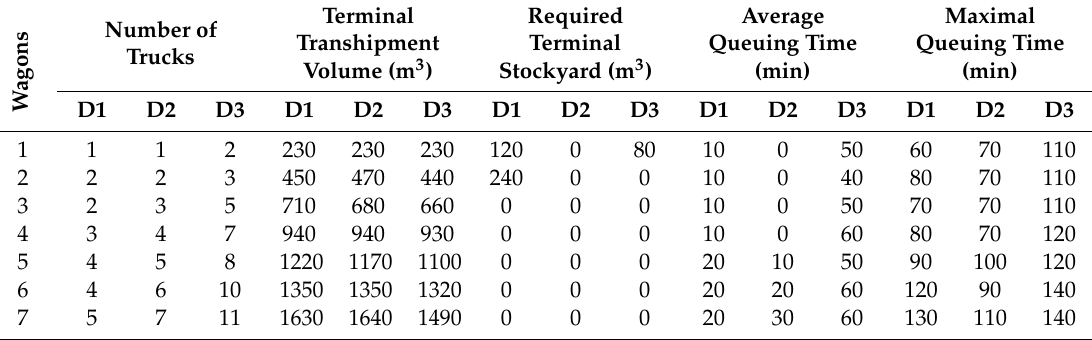
Table 6. Best performing simulation results for strategy BEST FIT (at least 90% terminal transhipment volume) for one train